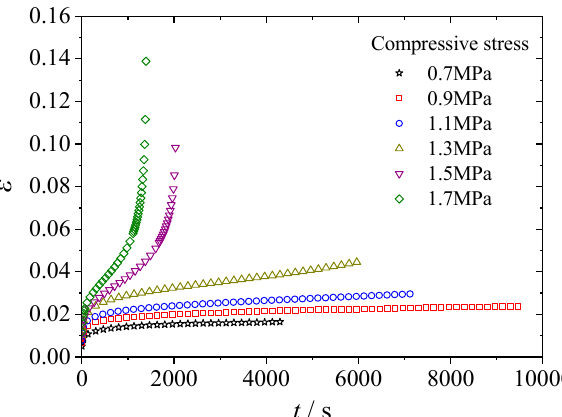
Figure 7. Creep curves of asphalt mixture under various compressive stress levels.